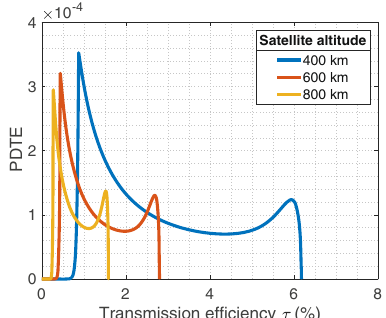
Fig. 3 PDTE for three different orbits of increasing satellite altitude. The values of the variables for each orbit are the same as in Fig. 2.